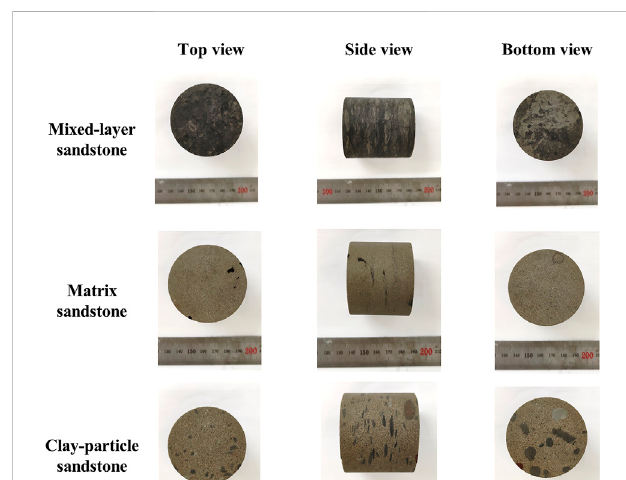
FIGURE 1 The pictures of core samples.